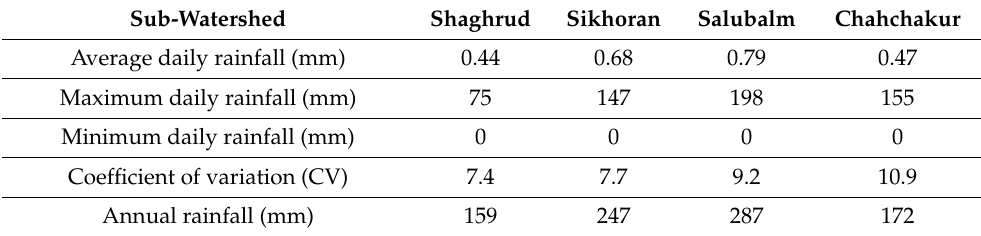
Table 2. Characteristics of daily and annual rainfall in